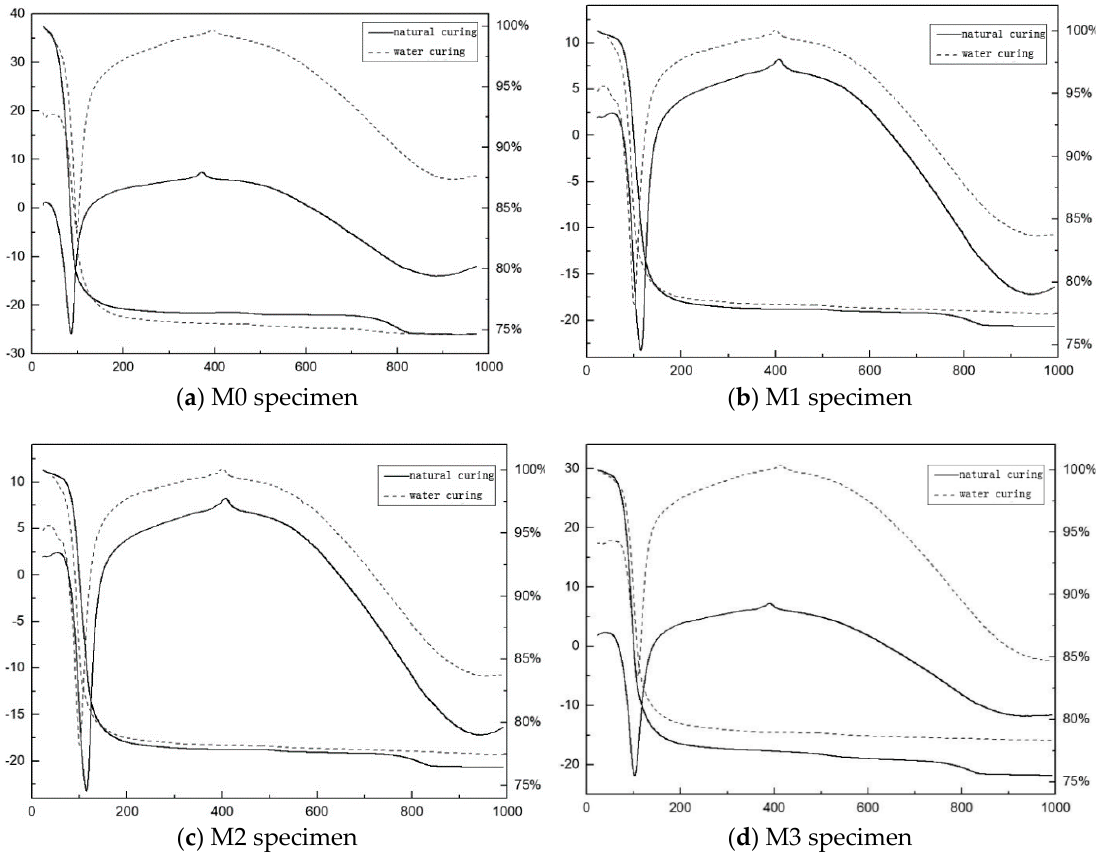
Figure 5. Thermogravimetry/differential thermal analysis (TG/DTA) curves of MKPC mortar under different curing conditions.